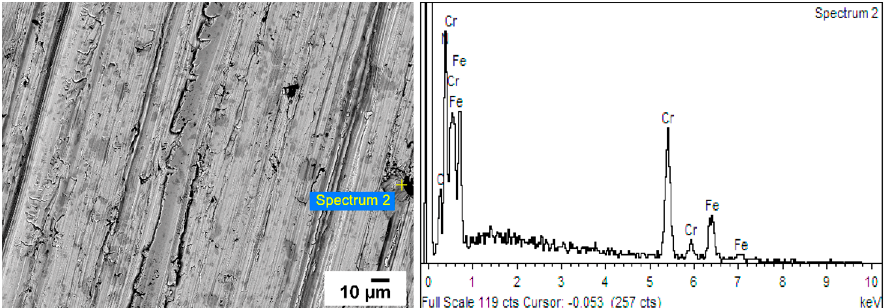
Figure 10. Worn surface after the “B” treatment and EDX spectrum from a pushed pattern.